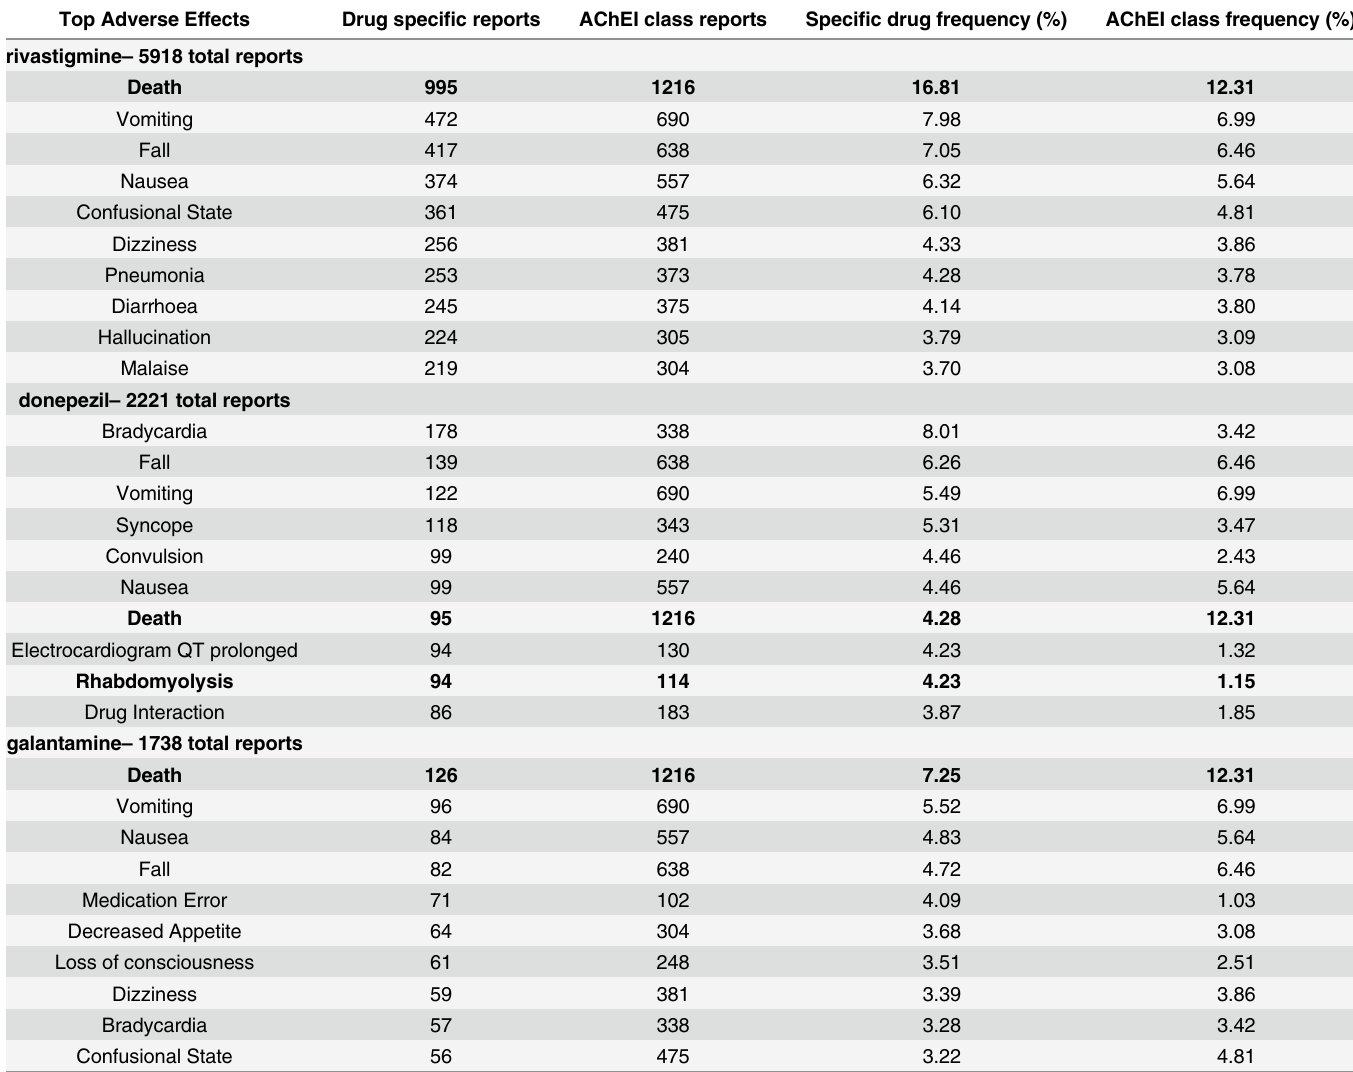
Table 1. Top adverse effects for cholinesterase inhibitors in FAERS